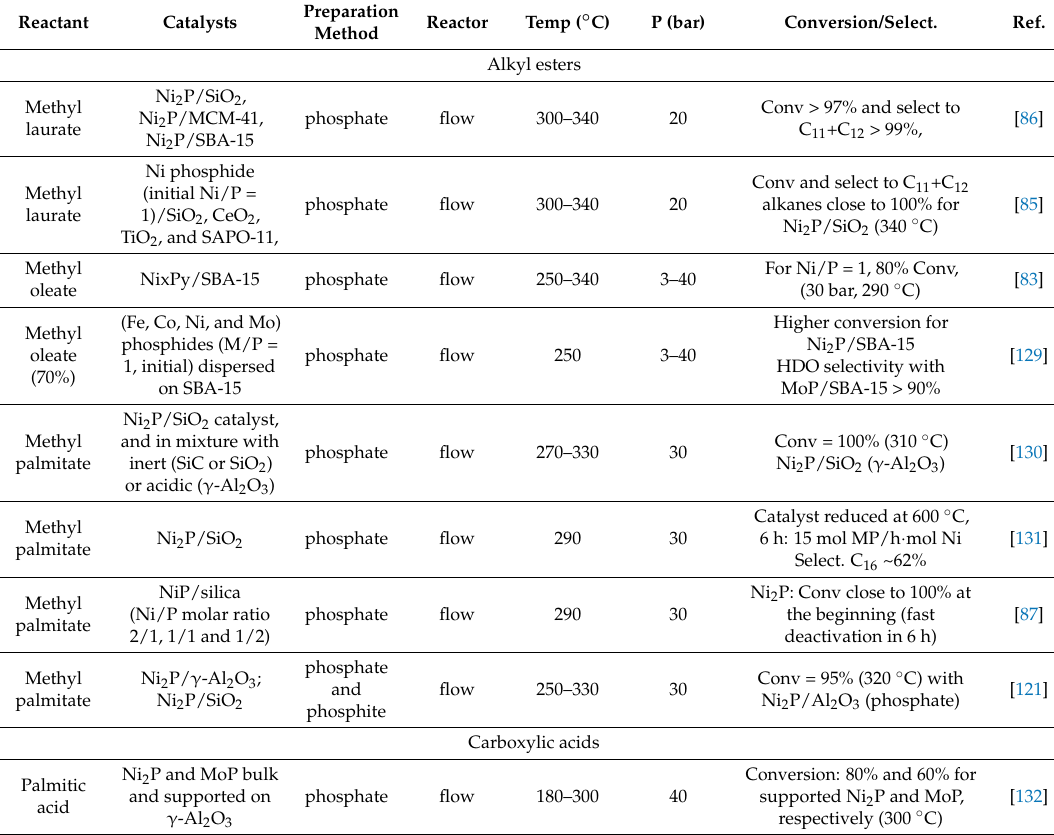
Table 2. Some literature studies on HDO of hydrotreated vegetable oils (HVO) (model compounds).